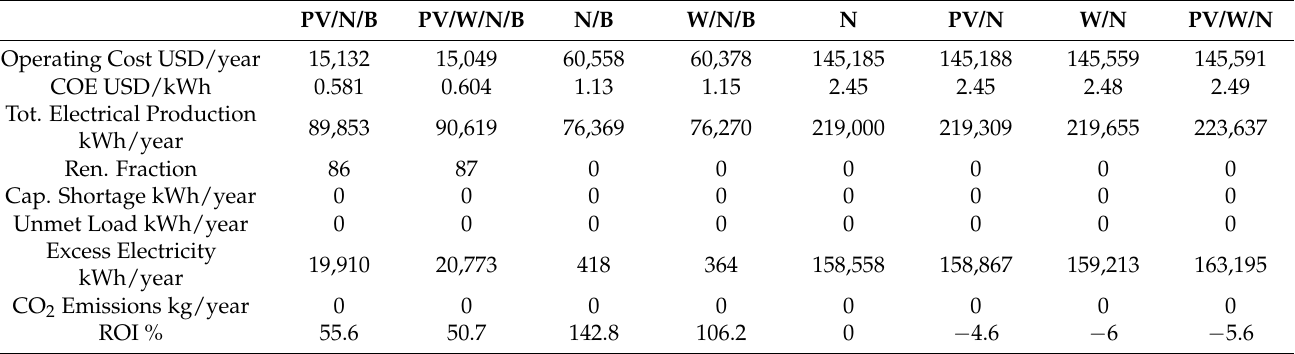
Table 2. HOMER output for scenario 1 with nuclear energy and renewable sources.